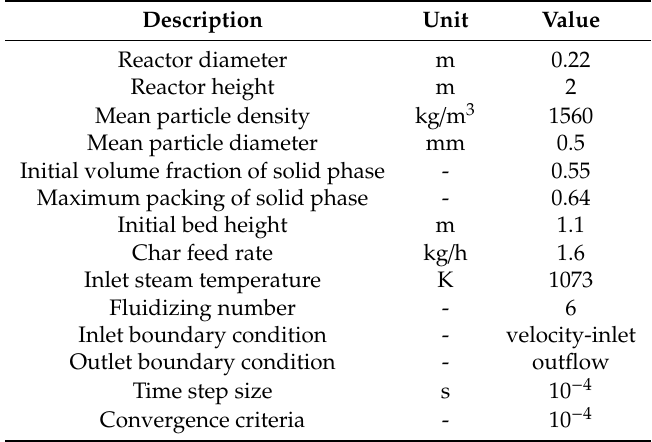
Table 2. Model parameters and initial conditions applied to the